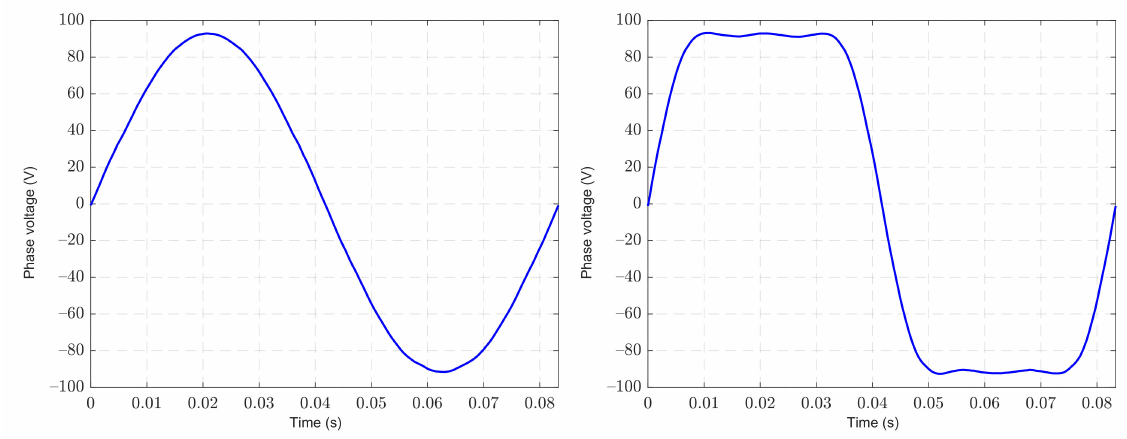
Figure 9. Voltage waveforms of single and higher order harmonic components